Question: Write a single sentence explaining what this figure depicts.
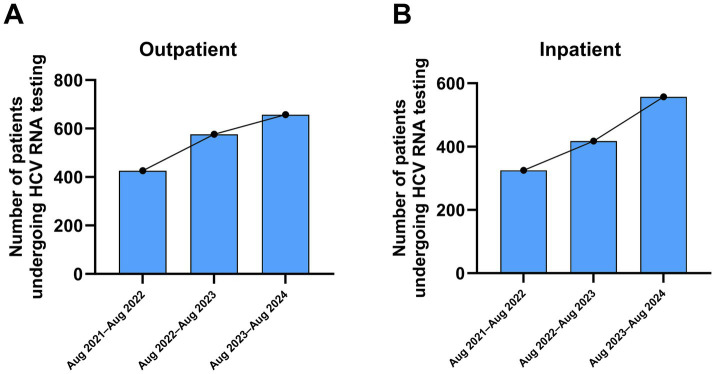
Answer: Trends in HCV RNA testing over time in outpatient and inpatient settings. (A) Outpatient setting and (B) inpatient setting. The figure illustrates the number of patients undergoing HCV RNA testing during three consecutive study periods (August 2021–August 2022, August 2022–August 2023, and August 2023–August 2024). The figure is intended to provide a descriptive illustration of temporal changes in HCV RNA testing following implementation of the hospital-based micro-elimination program.